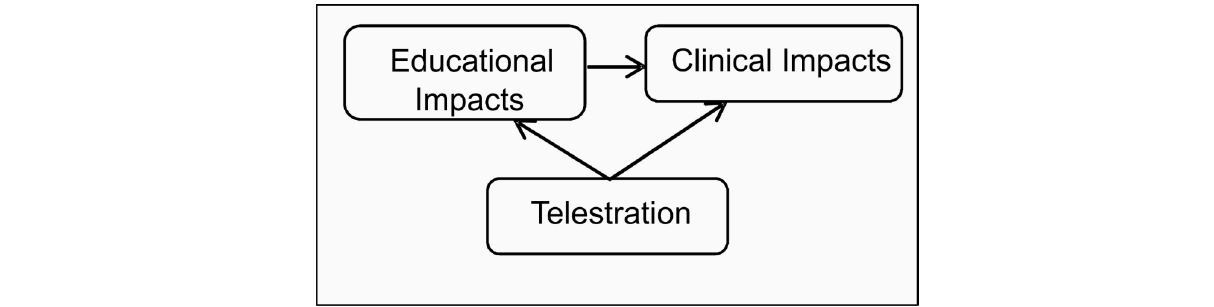
Figure 3. Impacts of telestration.